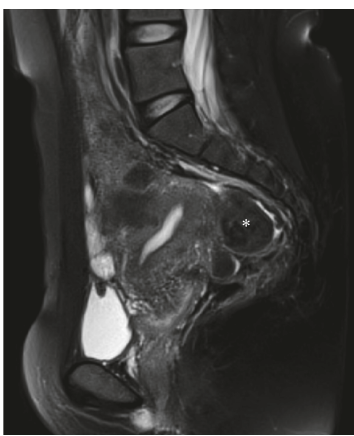
Figure 2: Sagittal T2-weighted MRI after delivery shows a large fibroid (white asterisk) located in